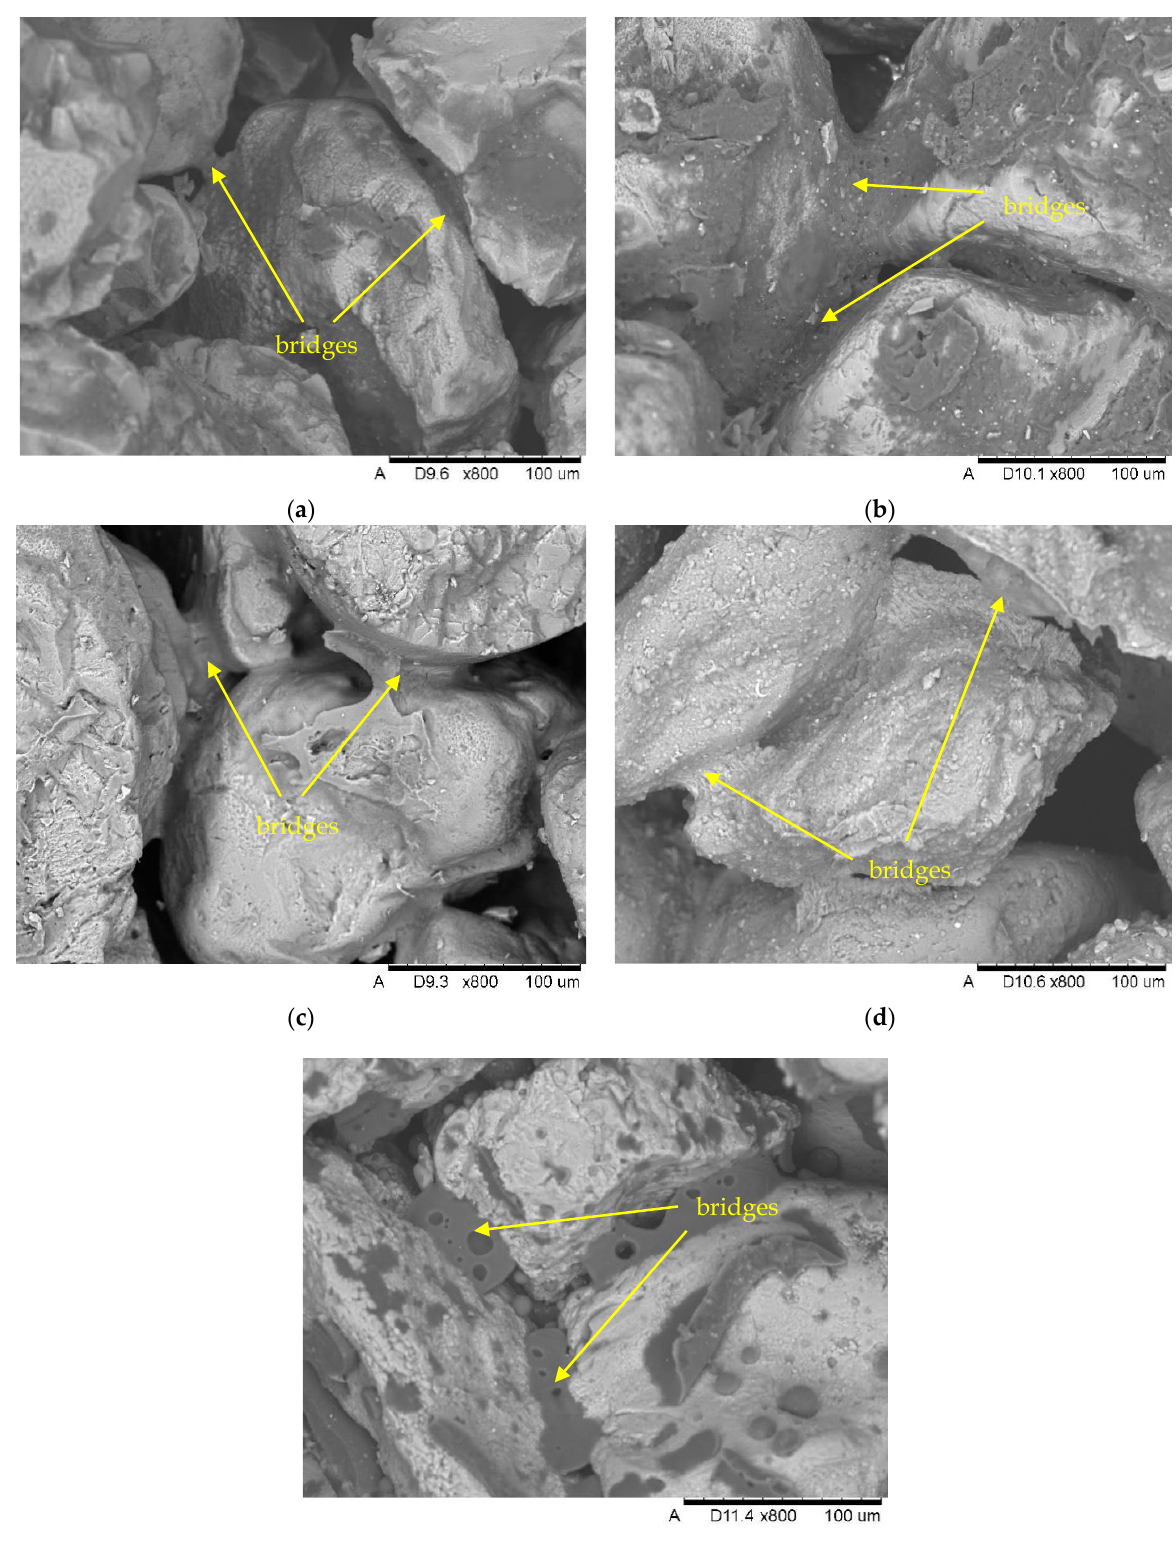
Figure 5. The surface morphology of molding sand for binders (SE imaging technique): ( a ) MB 2%, ( b ) MB 5%, ( c ) WG, ( d ) B 8%, ( e ) RCS.